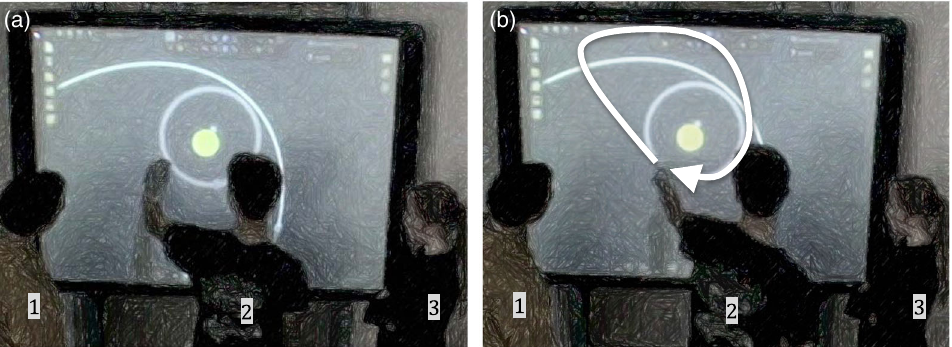
FIG. 6. The student continues to elaborate on his idea. He changes the hand with which he gestures and swings it vigorously while saying the words “ too fast. ” His finger in (b) is pointing towards a distant point out of the screen area (effectively extending the gesture space) to indicate that the planet, if thrown too fast, would fly far away. He supports this gesture with the words “ fly away. ”